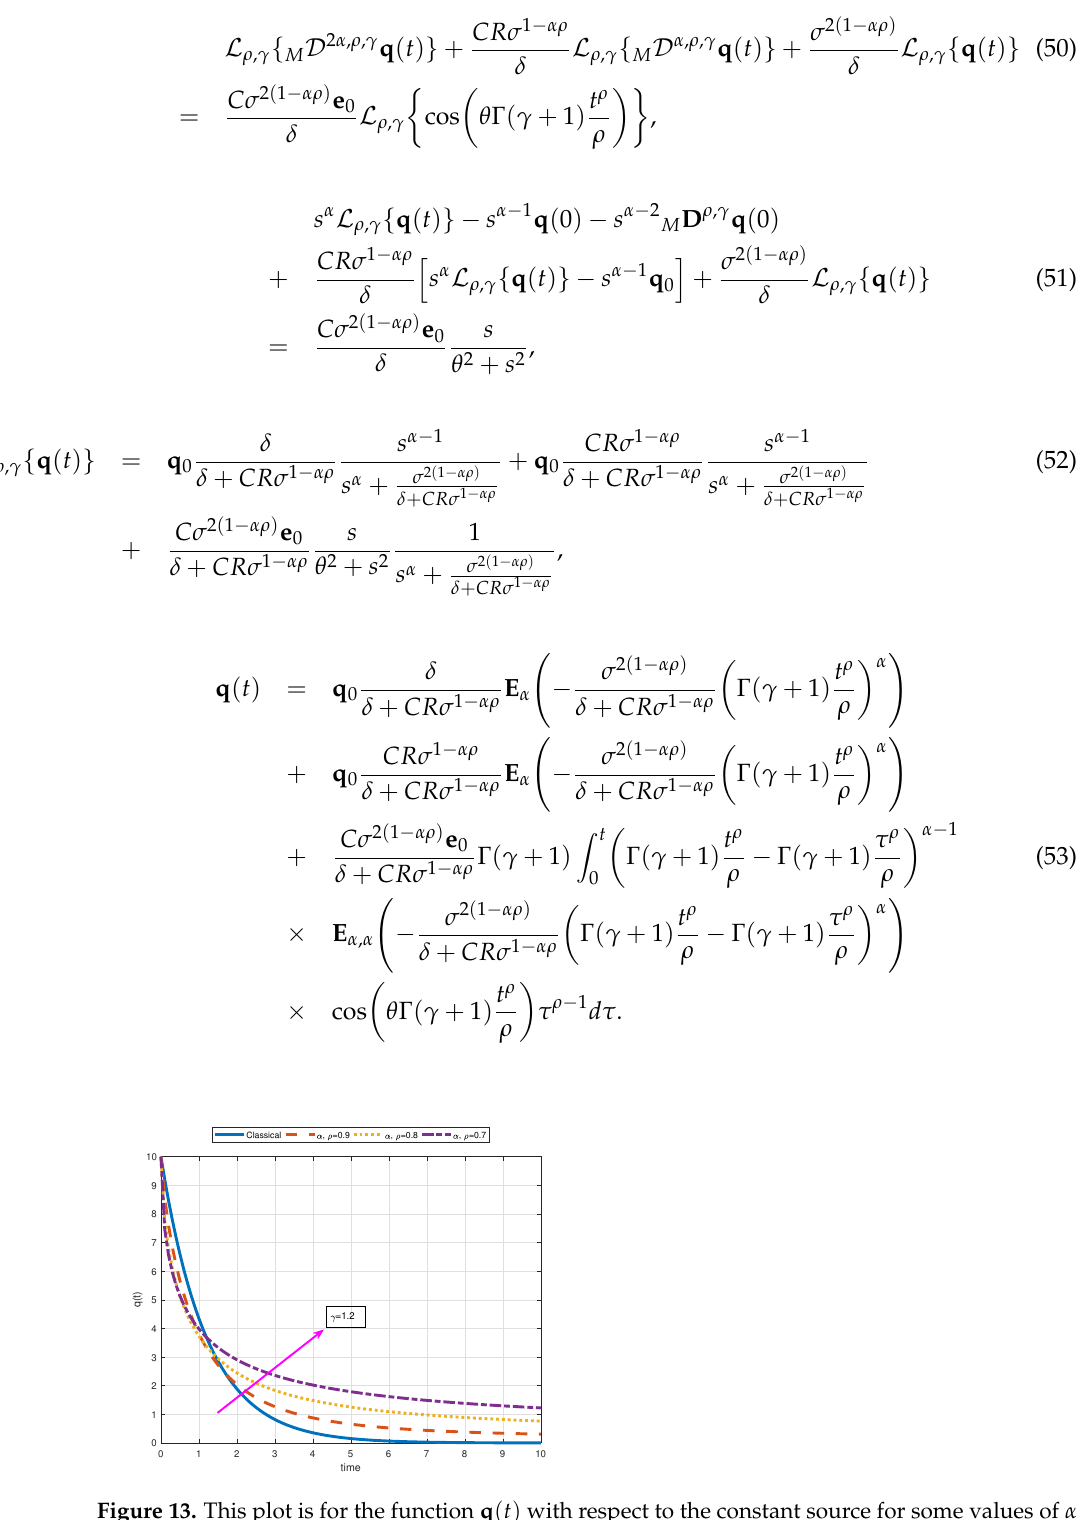
Figure 13. This plot is for the function q ( t ) with respect to the constant source for some values of α and ρ when γ = 1.2, R = 2 Ω , L = 10 H, C = 0.1 F, e 0 = 5 V, q ( 0 ) = 10, and M D α , ρ , γ q ( 0 ) =